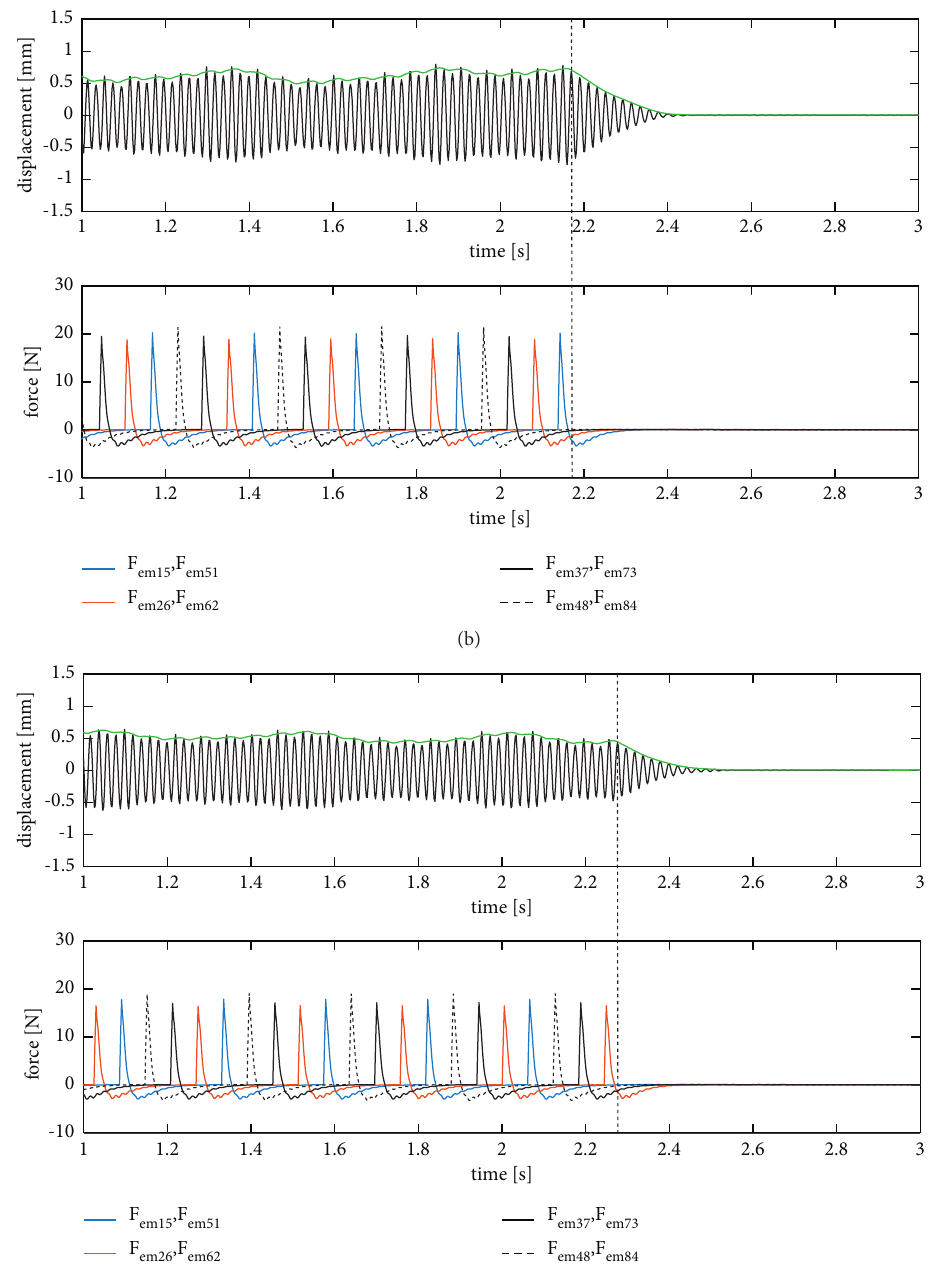
Figure 9: Vibration attenuation: mode 6ND, 123rpm contact prestress 2 N. (a) Test no. 6. (b) Test no. 5. (c) Test no.